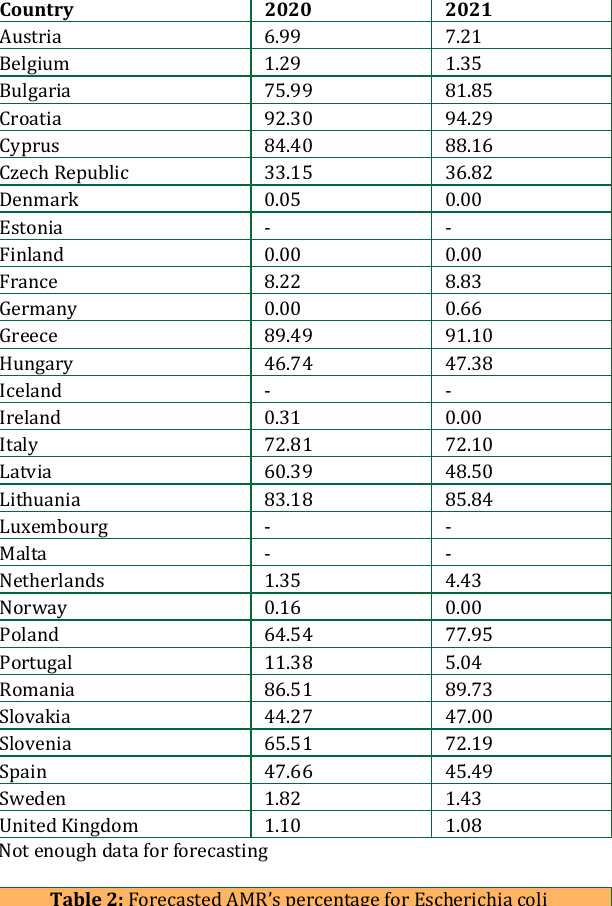
Table 1: Forecasted AMR’s percentage for Acinetobacter spp. Country